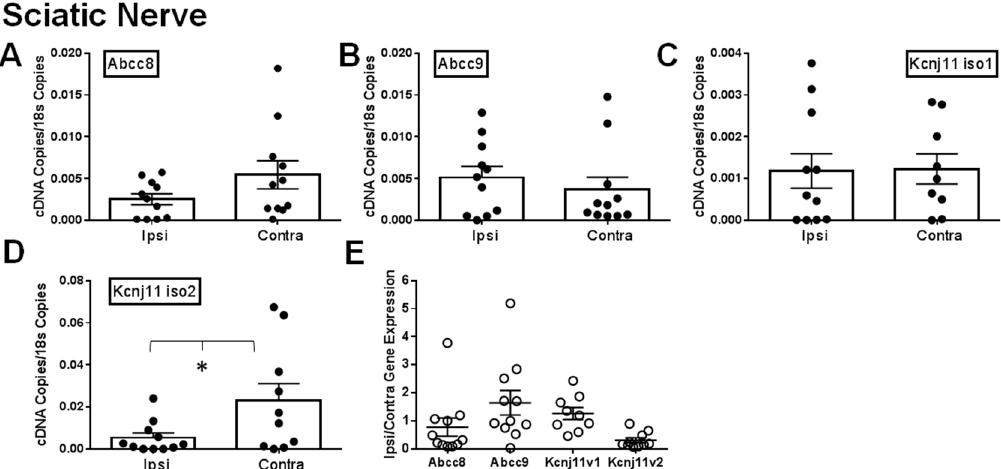
Figure 2. Expression of K ATP channel subunits in sciatic nerves are decreased after spinal nerve ligation (SNL). Relative expression of K ATP channel subunits in ipsilateral (Ipsi) and contralateral (Contra) sciatic nerves > 30 days post SNL. Relative gene expression for Abcc8 (protein: SUR1 , A ), Abcc9 (protein: SUR2, B ), Kcnj11 iso1 (protein: Kir6.2, C ) and Kcnj11 iso2 (protein: Kir6.2, D ) compared against matching tissue expression for 18s . * p < 0.05 comparison between Ipsi vs. Contra . ( E ). Data in A–D are expressed as mean fold change (Ipsi / Contra) between matching samples.